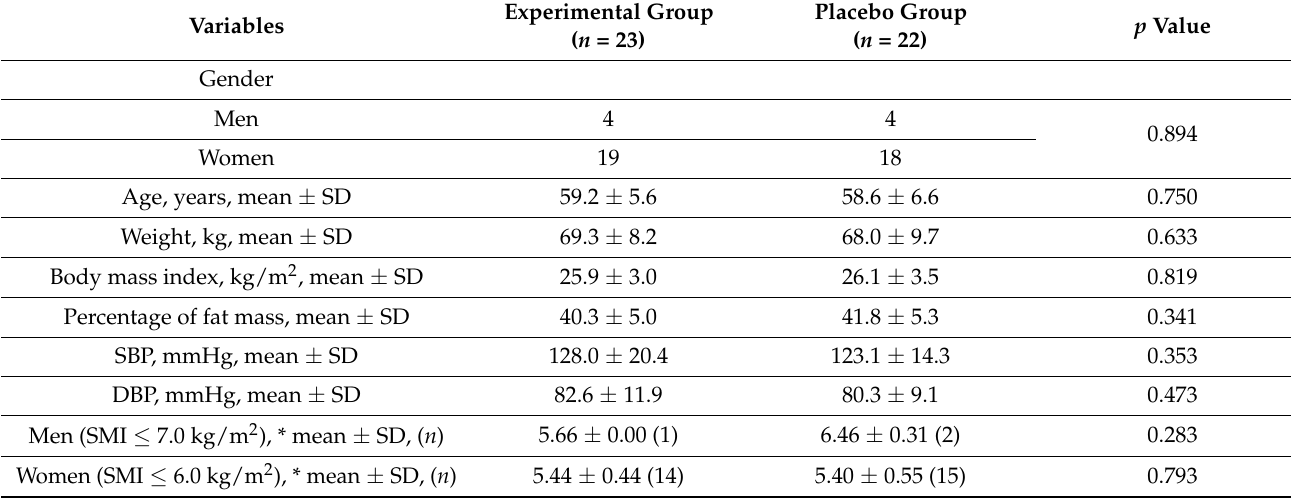
Figure 1. Flow chart of the study population. Table 1. Baseline characteristics of participants.